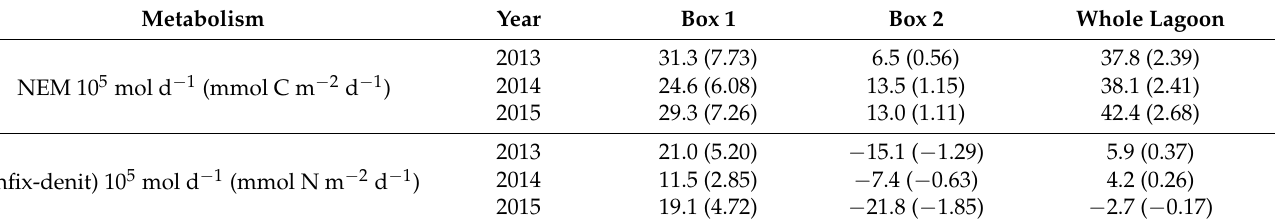
Table 3. Total and areal (in brackets) annual rates of Net Ecosystem Metabolism (NEM) and net difference between N 2 -fixation and denitrification (nfix-denit) calculated in Box 1 and 2 and in the whole Curonian Lagoon. Positive values indicate the dominance of net production over respiration for NEM and N 2 -fixation over denitrification for nfix–denit; negative values have opposite meaning. Metabolism Year Box 1 Box 2 Whole